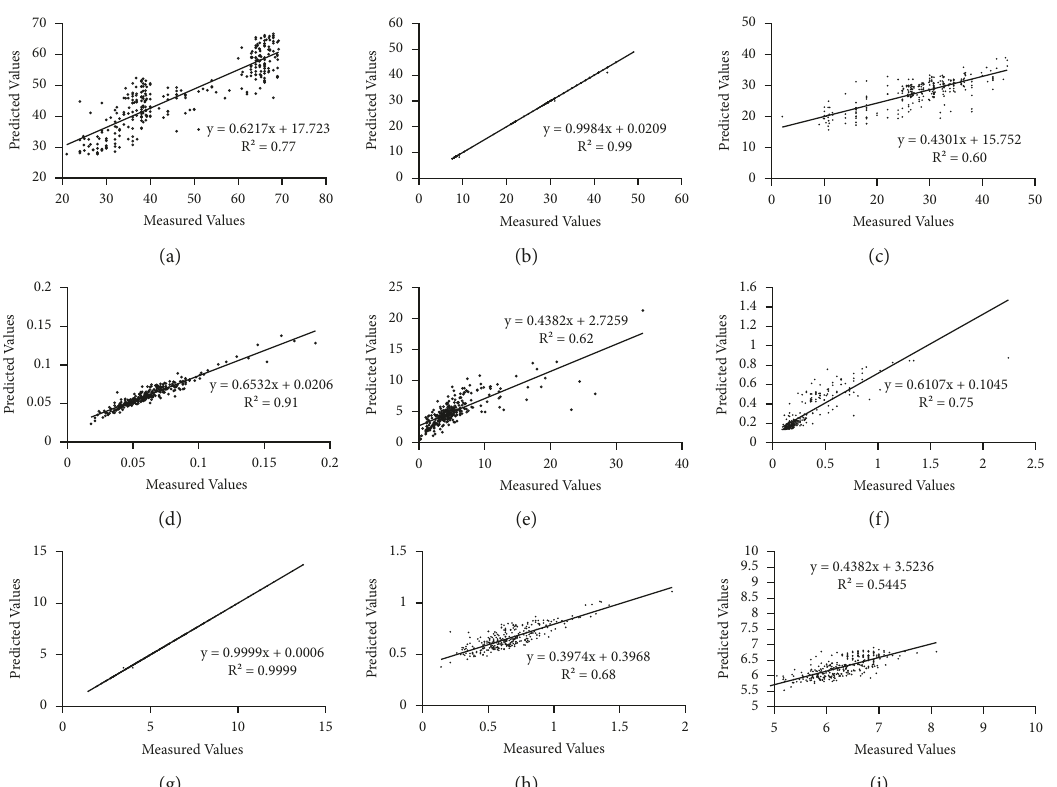
effective cation exchange capacity and (cid:28)